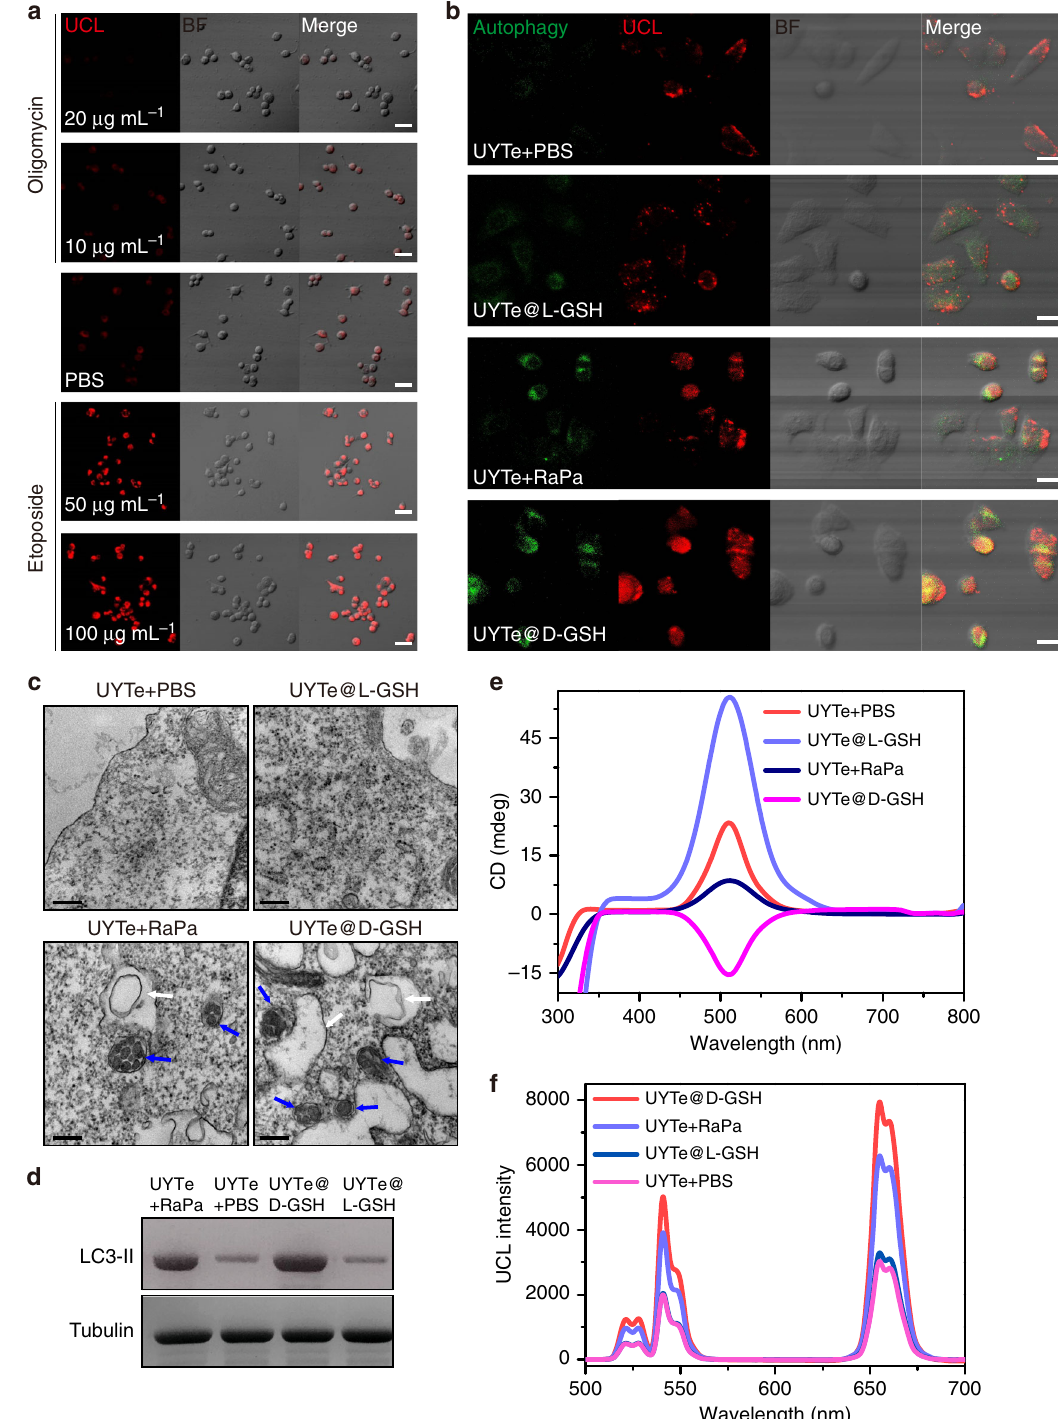
Fig. 4 Chirality-dependent autophagy inducing and ATP quanti fi cation in living cells. a The UCL confocal images of MCF-7 cells (5 × 10 7 ) treated